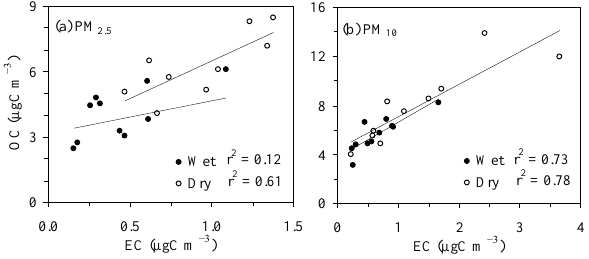
Fig. 4. Relations between OC and EC in (a) PM 2 . 5 and (b) PM 10 during the wet and dry seasons in